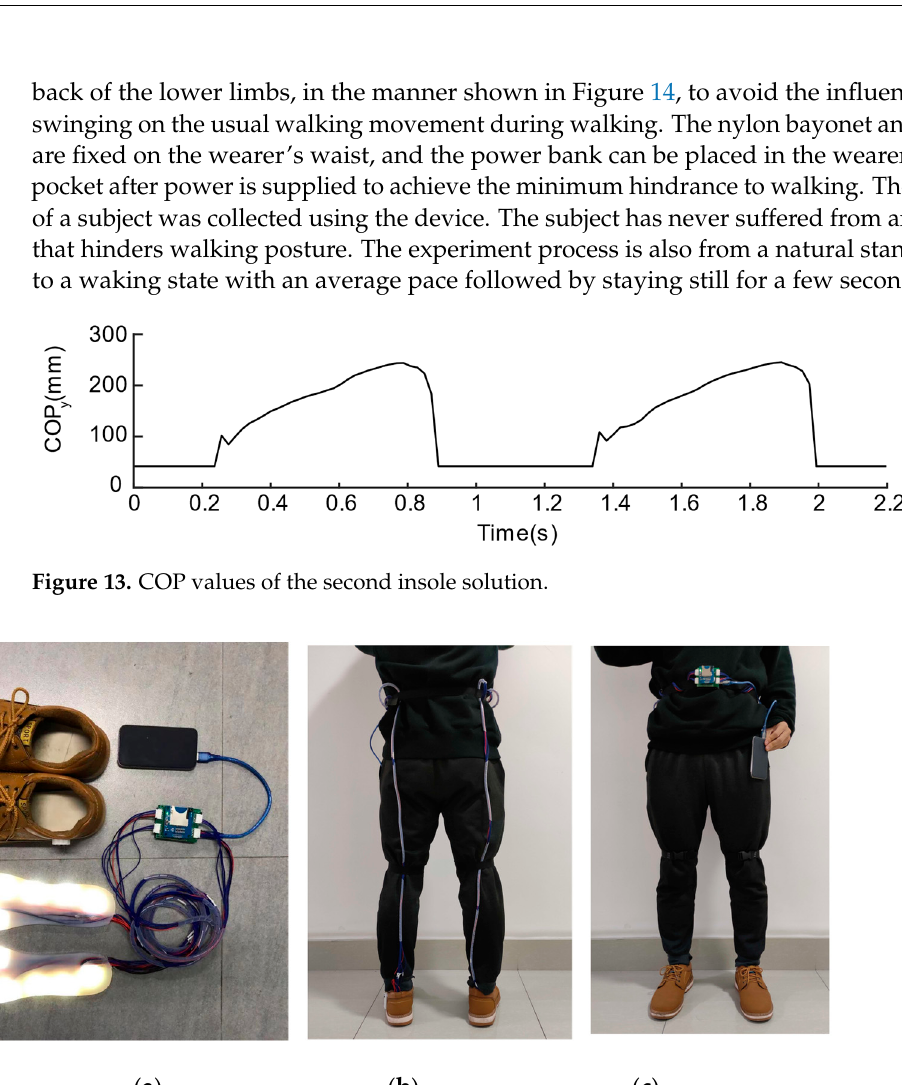
Figure 14. The experimental setup. ( a ) equipment used ( b ) sensing system setup back view ( c ) sensing system setup front view.